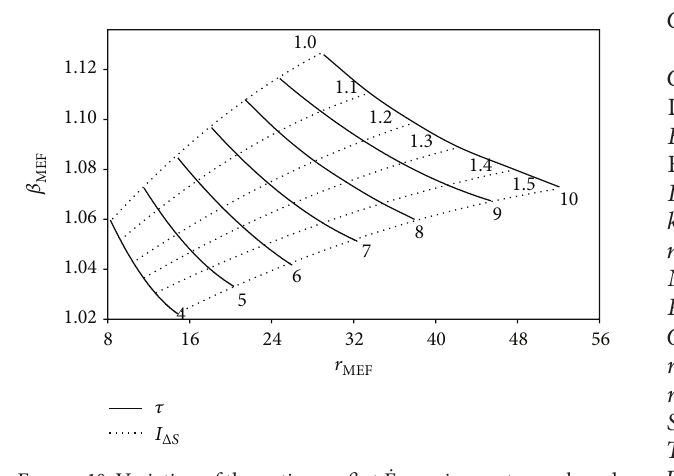
Figure 10: Variation of the optimum 𝛽 at on the optimum 𝑟 , for various 𝜏 and 𝐼 Δ𝑆 values ( 𝑇 0 = 𝑇 𝐿 = 300 K, 𝑋 = 0.3 , and 𝜉 = 0.02 ).